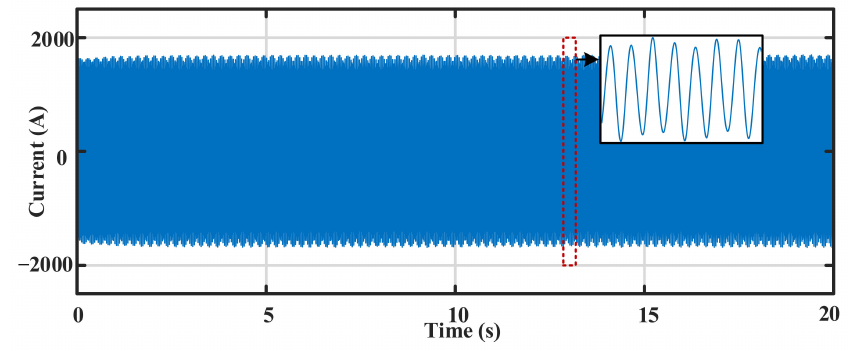
Figure 16. Current waveform of a wind farm in Hami.